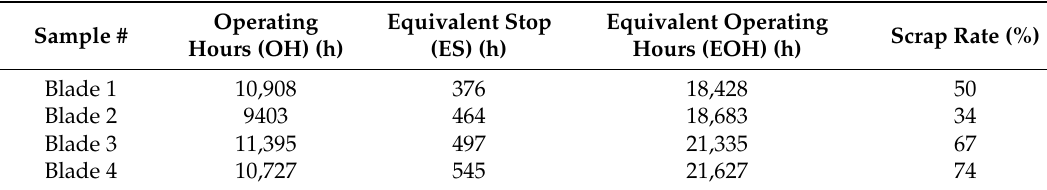
Table 2. The scrap rate and operational information of service-exposed blades in the gas turbines of power plant